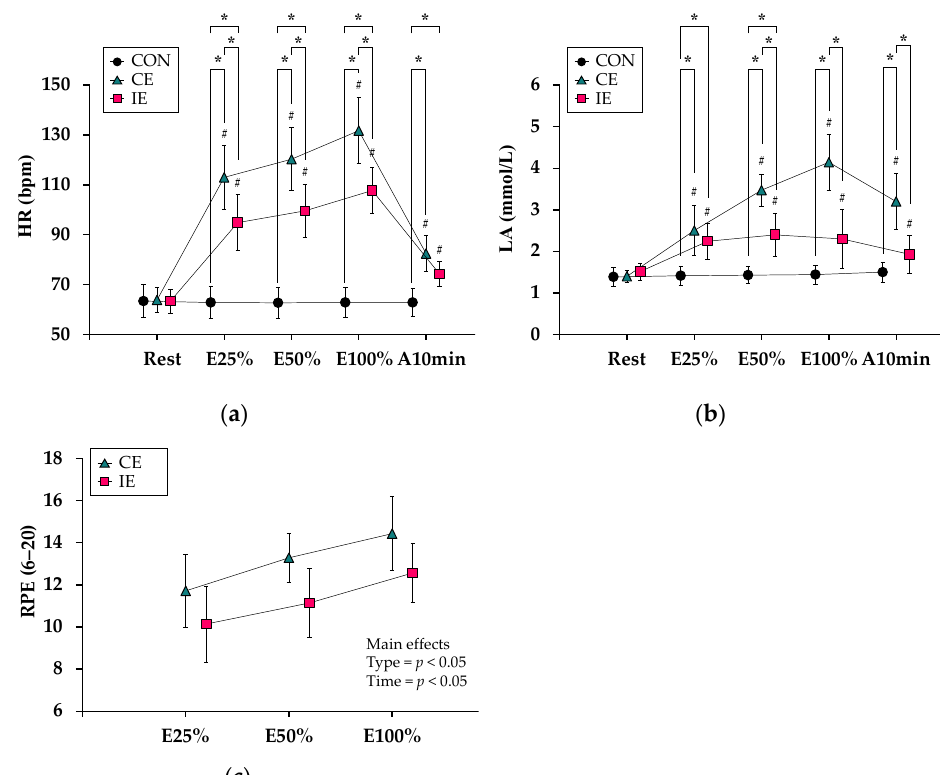
Figure 2. Responses of variables related to a degree of exhaustion (conventional biomarkers): Values of ( a ) heart rate (HR), ( b ) blood lactate concentration (LA), and ( c ) Borg rating of perceived exertion (RPE) are displayed. The circle, triangle, and cube indicate control (CON), continuous exercise (CE), and intermittent exercise (IE) values, respectively. *: p < 0.05 indicates [type]. #: p < 0.05 indicates [time] with Rest.